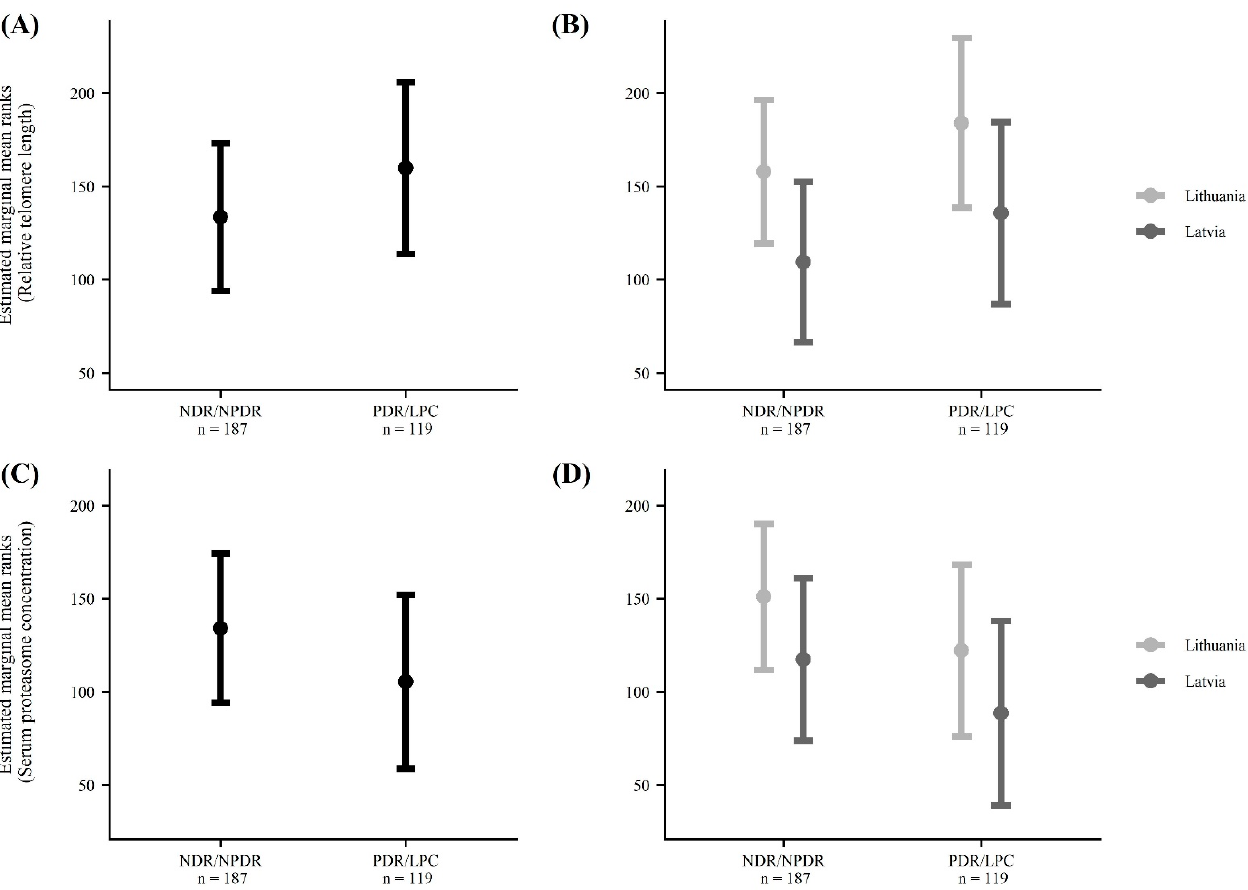
Figure 1. Telomere length and serum proteasome concentration in patients with different severities of diabetic retinopathy in Latvia and Lithuania. NDR/NPDR—no diabetic retinopathy/non-proliferative retinopathy; PDR/LPC—proliferative retinopathy/status after panretinal-laser photocoagulation. ( A ) Telomere length in the whole cohort was stratified according to diabetic retinopathy status. p = 0.036 between NDR/NPDR and PDR/LPC after controlling for the country, duration of diabetes, waist/hip ratio, serum triglycerides and eGFR. ( B ) Telomere length in patients with different severities of diabetic retinopathy stratified by country. ( C ) Circulating proteasome concentrations in the whole cohort stratified according to diabetic retinopathy status. p = 0.0234 between NDR/NPDR and PDR/LPC after controlling for the country, duration of diabetes, waist/hip ratio, serum triglycerides and eGFR. ( D ) Circulating proteasome concentration in patients with different severities of diabetic retinopathy stratified by country.